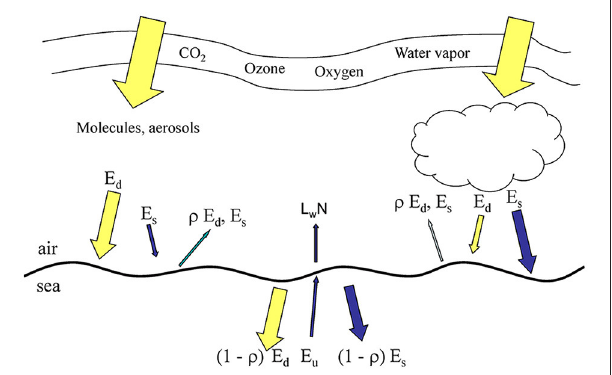
FIGURE 1 | Irradiance pathways (directional irradiance) in OASIM. E d is direct downwelling irradiance, E s is diffuse downwelling, ρ is surface reflectance, E u is diffuse upwelling irradiance, and LwN is normalized water-leaving radiance. All irradiances and radiances are spectrally resolved at 25 nm for E d , E s , and E u for the range 350–700 nm, and at variable resolution for the remainder of the 200 nm–4um. Size of arrows approximates relative